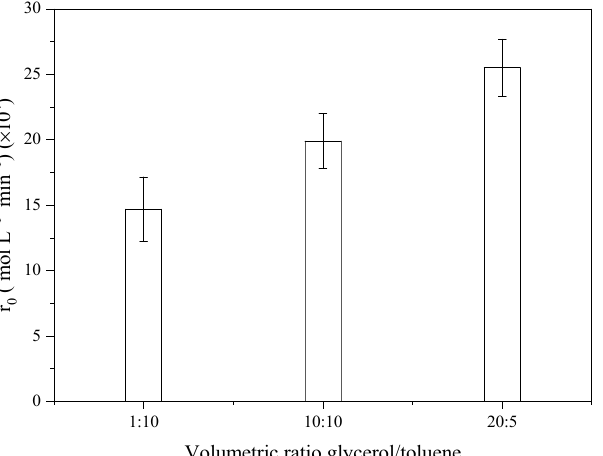
Figure 3. Effect of the volume ratio of the solvents on the esterification of ibuprofen with glycerol using toluene as solvent in the apolar phase at T = 70 ◦ C, C I0 = 60 g · L − 1 , N = 720 rpm over initial reaction rate.